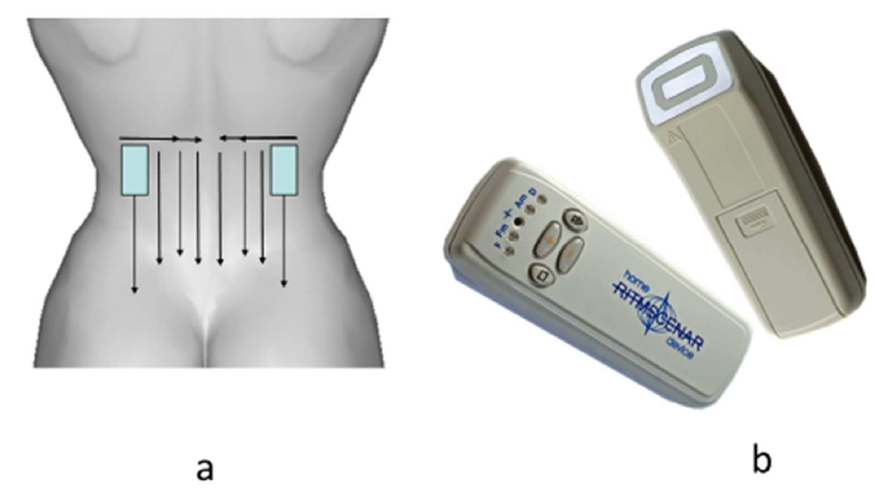
Figure 1. The template of application of SCENAR in the lumbar region ( a ) and type of device ( b ).